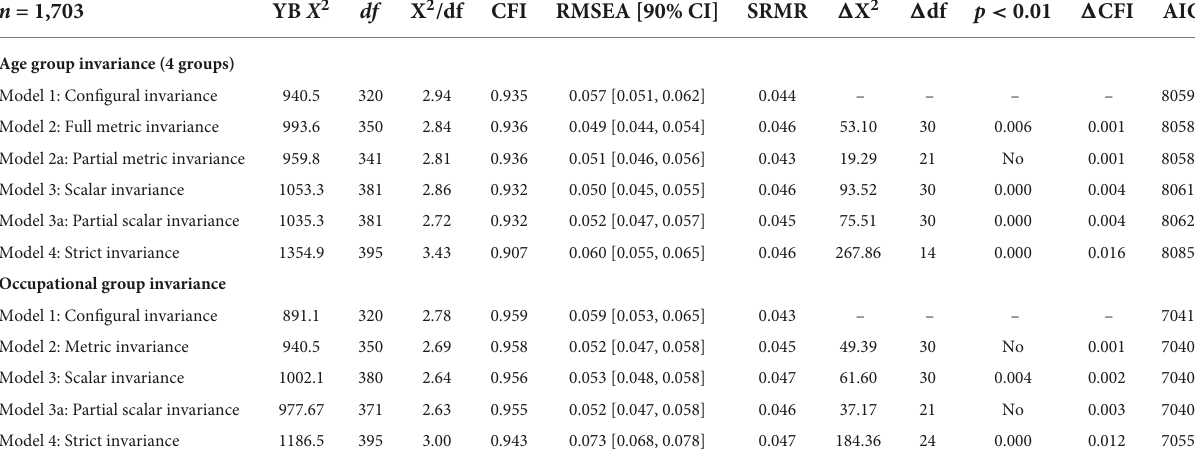
TABLE 6 Goodness-of-fit indices for measurement invariance models for the five-factor higher-order Death Reflection